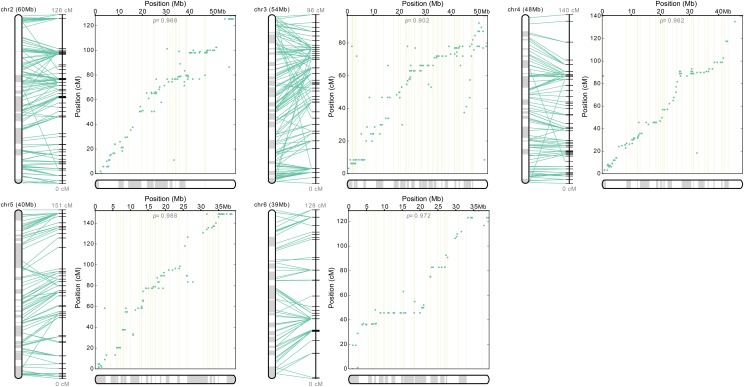
Superscaffolded map integrating linkage information from all chromosomes. For each linkage group the y-axis shows the position of each marker and its corresponding scaffold in the linkage map in centimorgans. On the x-axis is the subsequent position of each scaffold in megabase pairs after superscaffold assembly. The alternating gray and white bars represent contiguous scaffolds. Each linkage group is connected to its subsequent chromosome with green horizontal lines which denote SNP positions in the linkage group and its subsequent placement in the superscaffold assembly. Crossing of green horizontal lines indicate points of conflict where the linkage position and superscaffold position are not linear. The ratio between the longest monotonic subsequence and the total number of markers in the linkage group (ρ) indicate high collinearity between SNP marker position and scaffold placement.